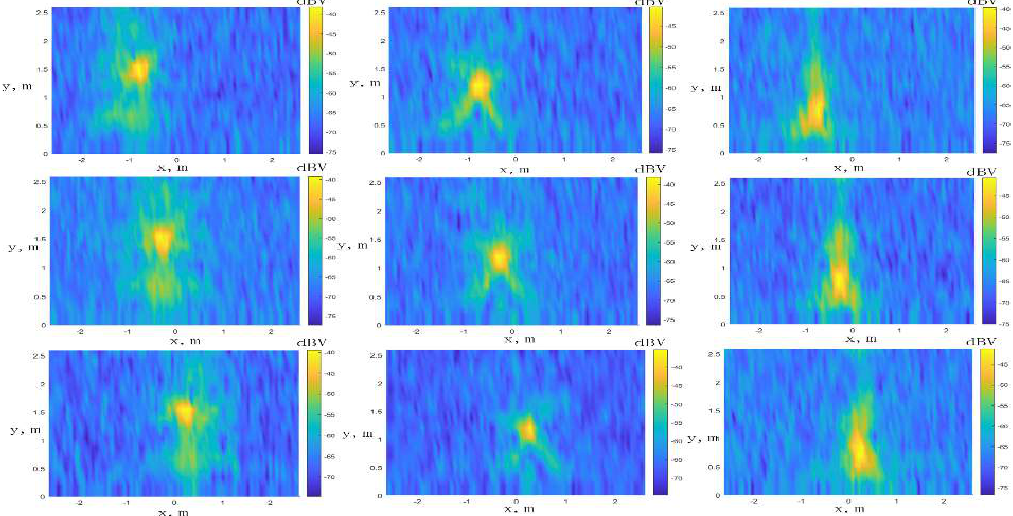
Figure 14. The electric field values vary as the locations of sources at 6 GHz.